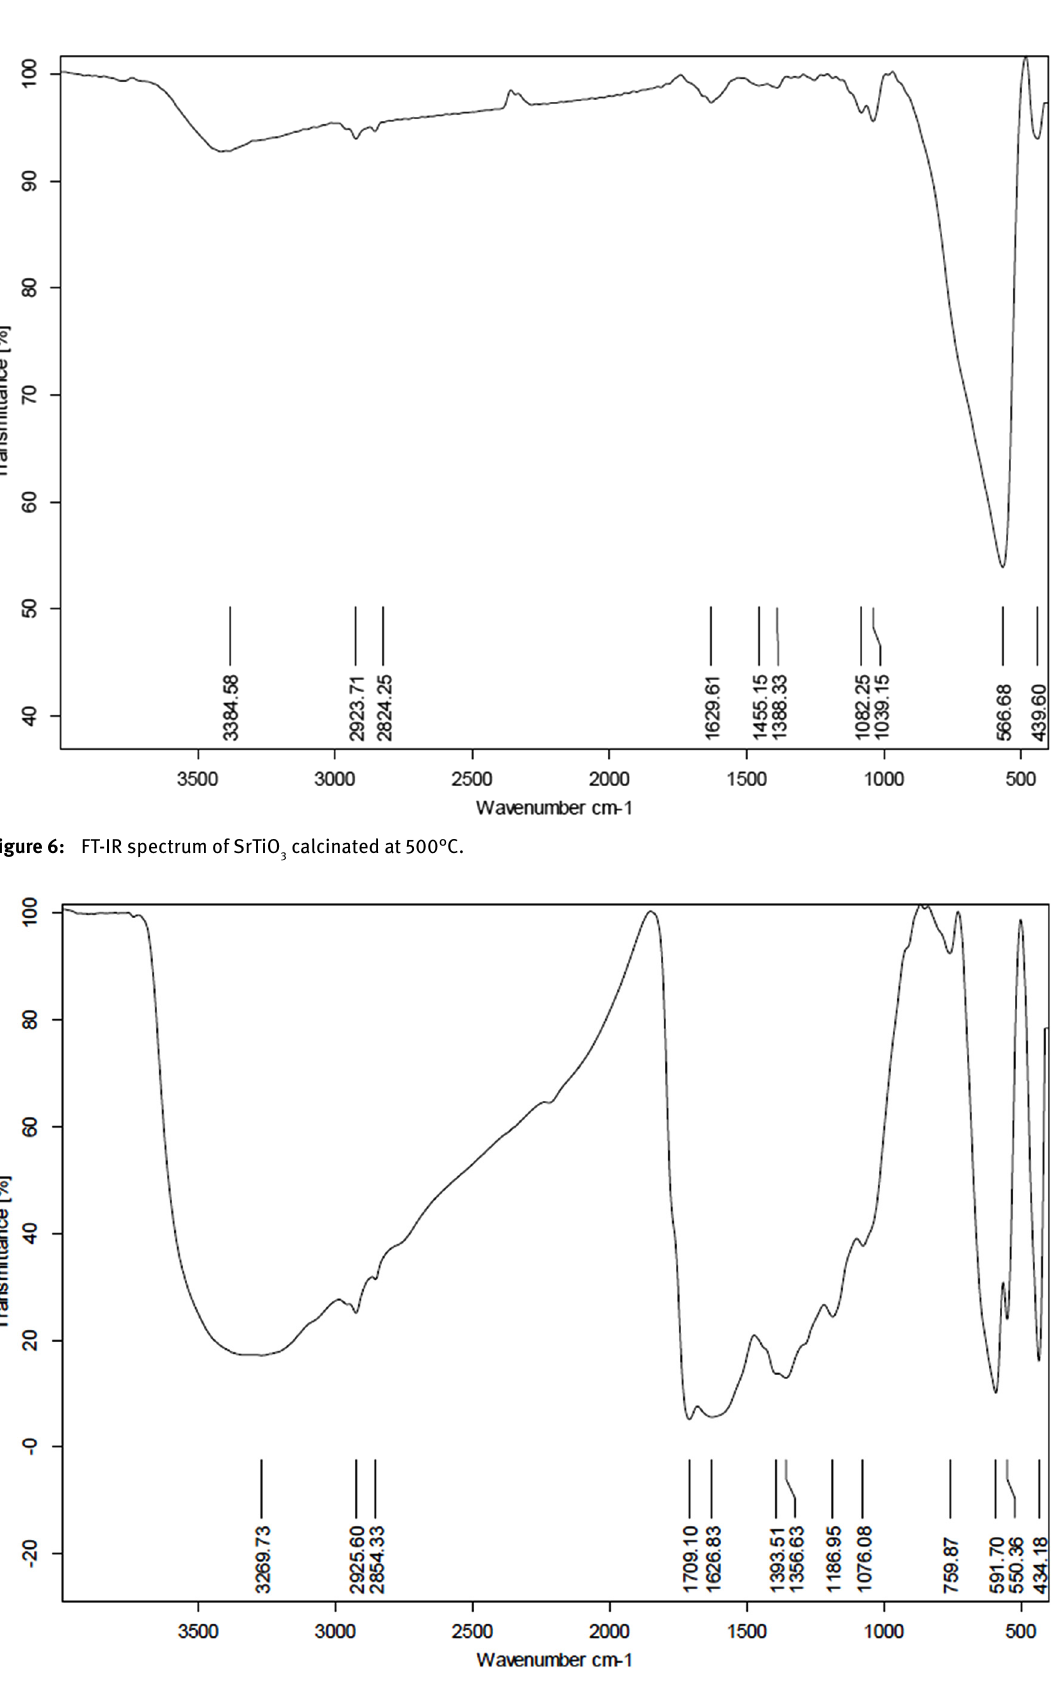
Figure 7: FT-IR spectrum of nanocomposite SrFe